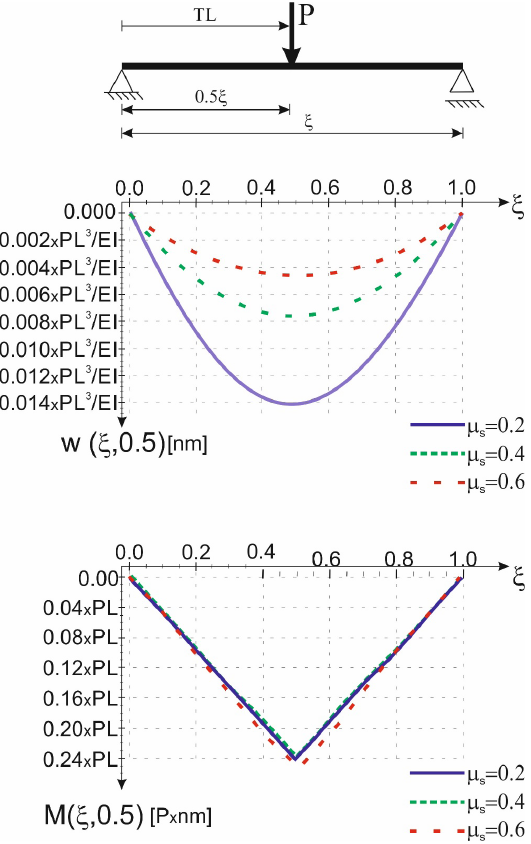
gradient model, the series converge faster than that in case of the stress gradient model.